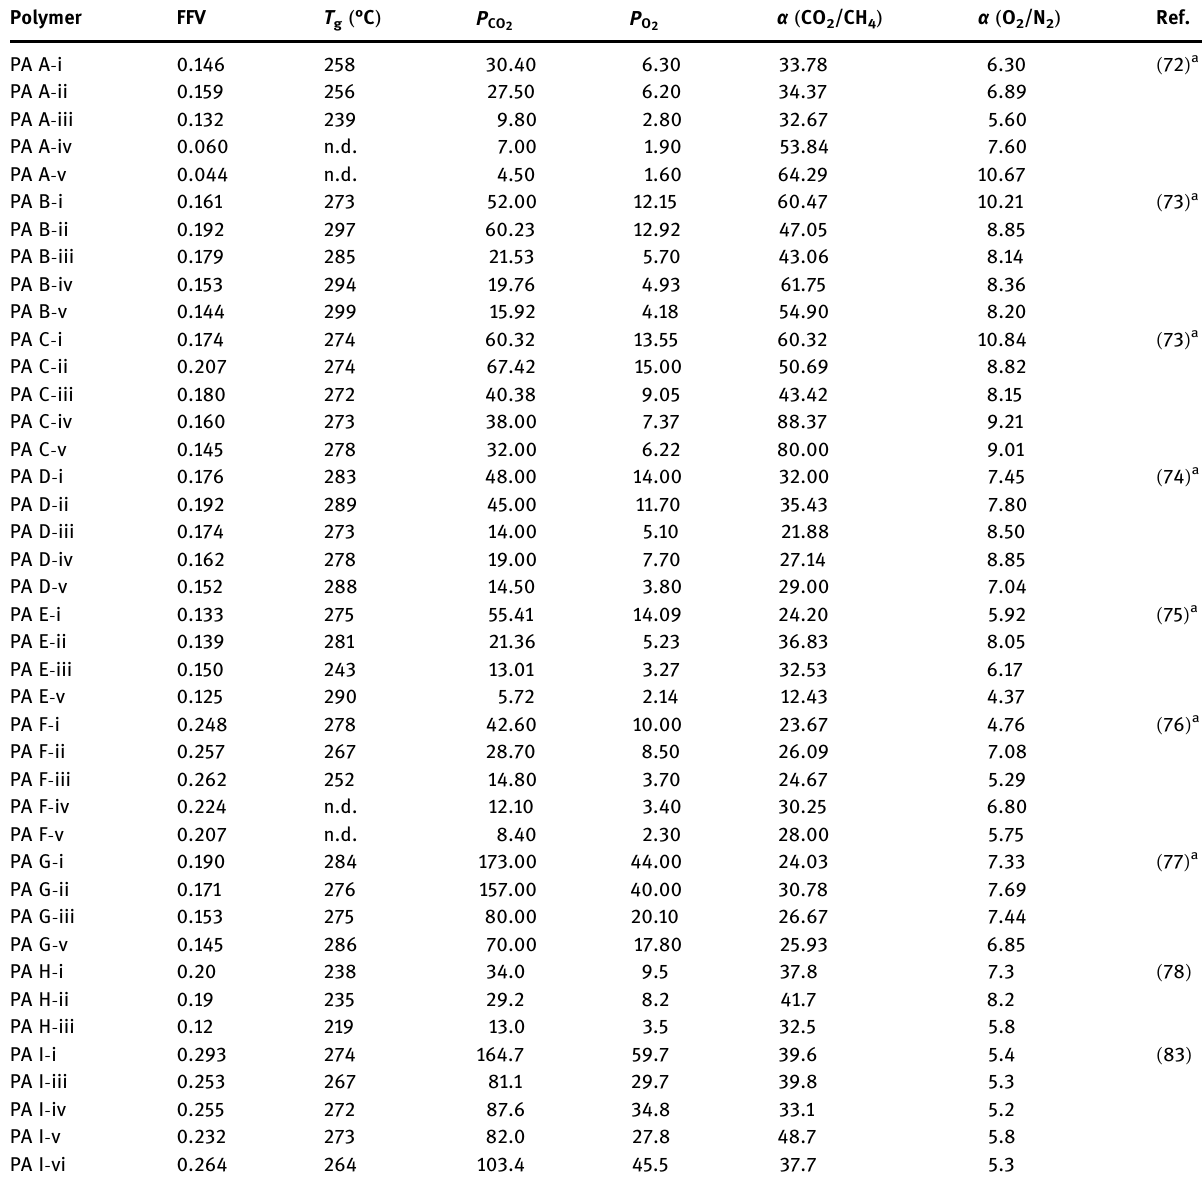
Table 9: FFV, T g , and gas permeability ( in Barrers ) and permselectivity values of the synthesized PAs measured at 3.5 bar pressure and 35°C